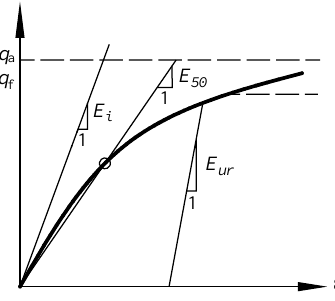
Fig. 4. Hyperbolic stress-strain relation in primary loading for a standard drained triaxial test